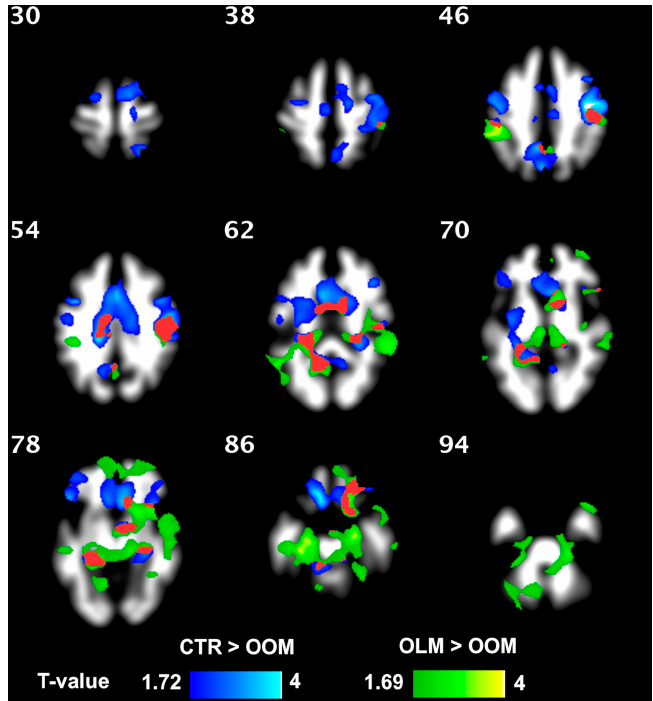
Figure 2. WM density was greater in OLM compared to OOM ( green ) and was greater in CTR than in OOM ( blue ). The two-color scales represent the t-values of the statistical test. The lowest visualized t -value in the color scales corresponds to p = 0.05. The red area shows the intersections between the two statistical maps.